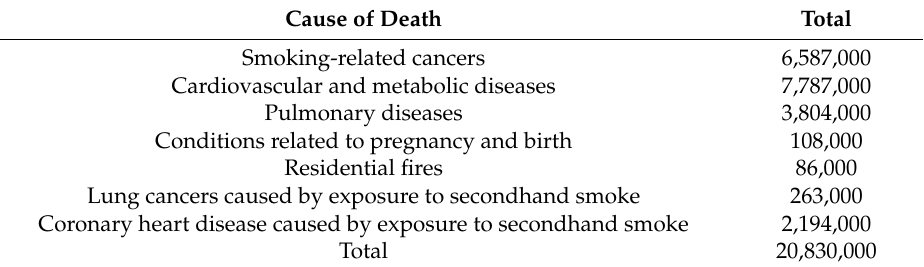
Table 1. Premature deaths caused by smoking and exposure to secondhand smoke, 1965–2014